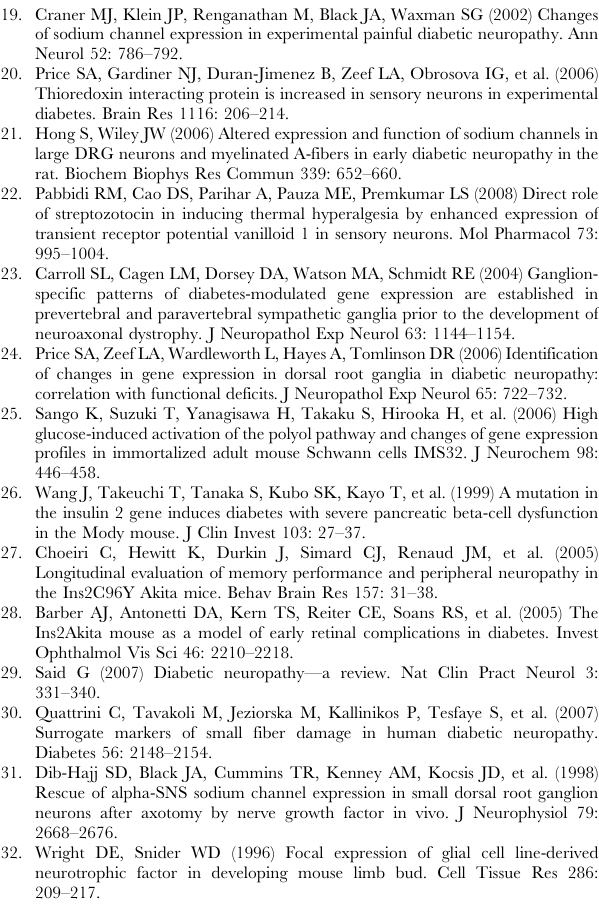
Figure S4 Expression of selected cholesterol metabolism related genes in sciatic nerve endoneurium samples. Normalized levels of